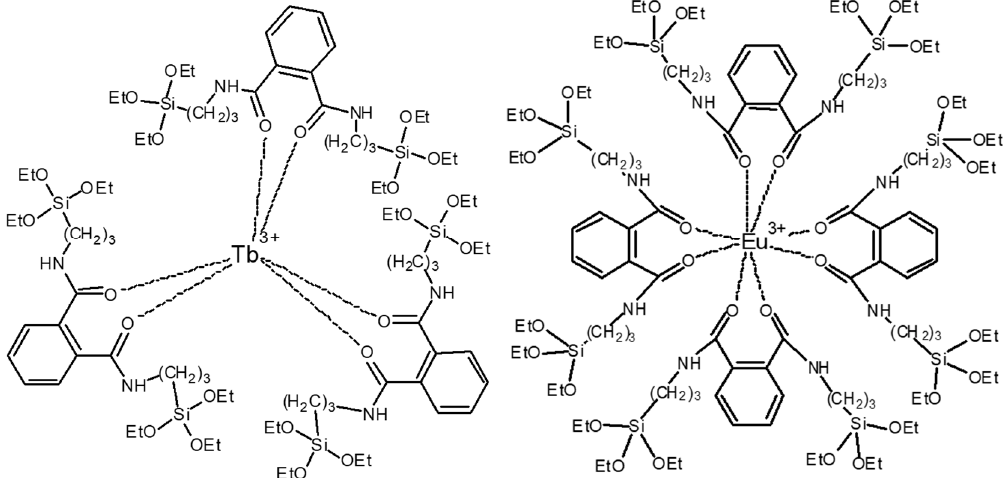
Figure 1. The structural formulas of Tb and Eu complexes.